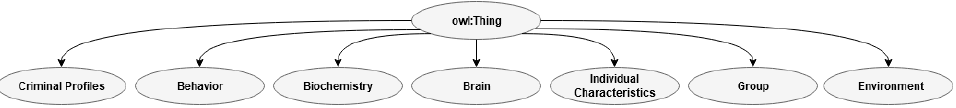
Figure 2. Top hierarchy of ontology. Behavior (B), biochemistry (B), brain (B), individual charac- teristics (I), and criminal profiles (CPs) represent the five IBBB-CP, while group and environment represent support